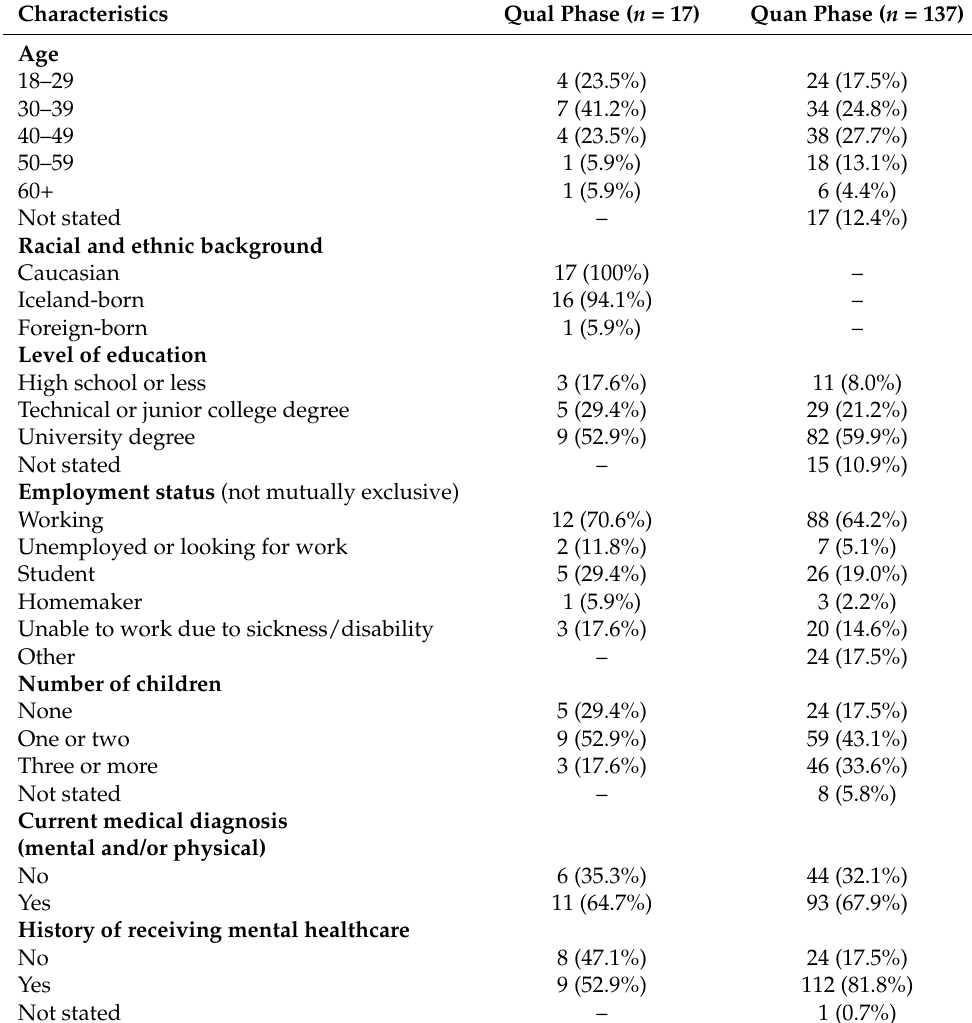
Table 1. Overview of the participants’ demographics